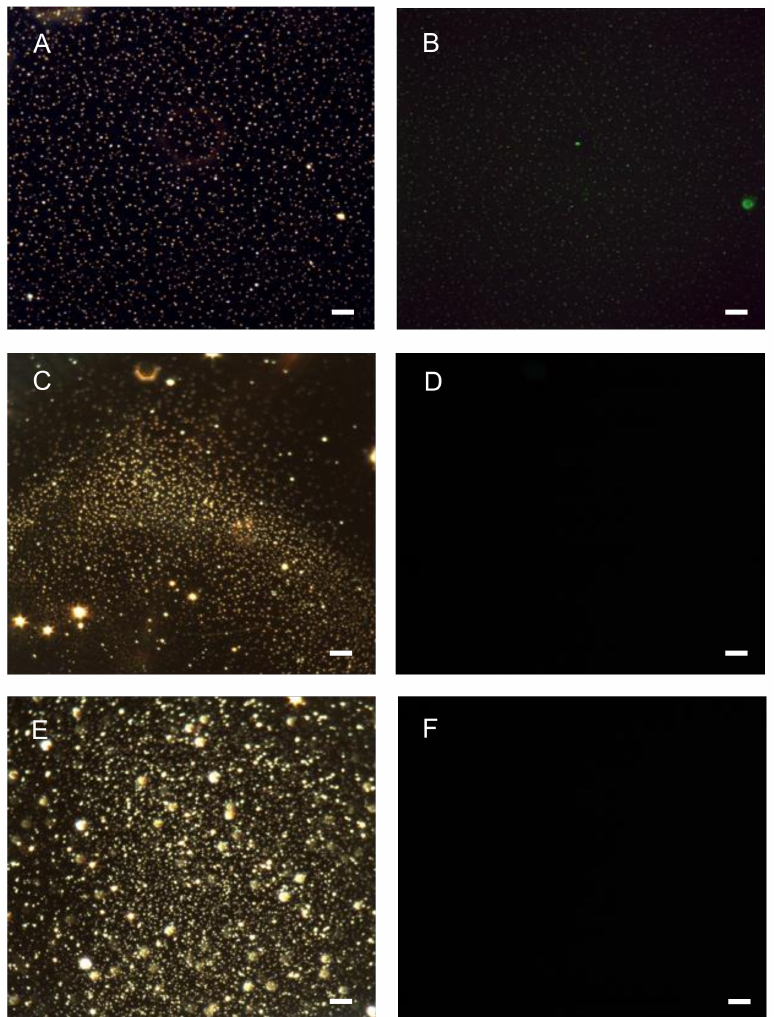
Figure4. ( A )Dark-fieldand( B )fluorescenceimagesofOliGreen ® taggedGNP-Gd(III)DO3A-SH-AS141. ( C ) Dark-field and ( D ) fluorescence images of GNP-Gd(III)-DO3A-SH and ( E ) Dark-field and ( F ) fluorescence images of non-OliGreen ® tagged GNP-AS1411. Scale bar = 10